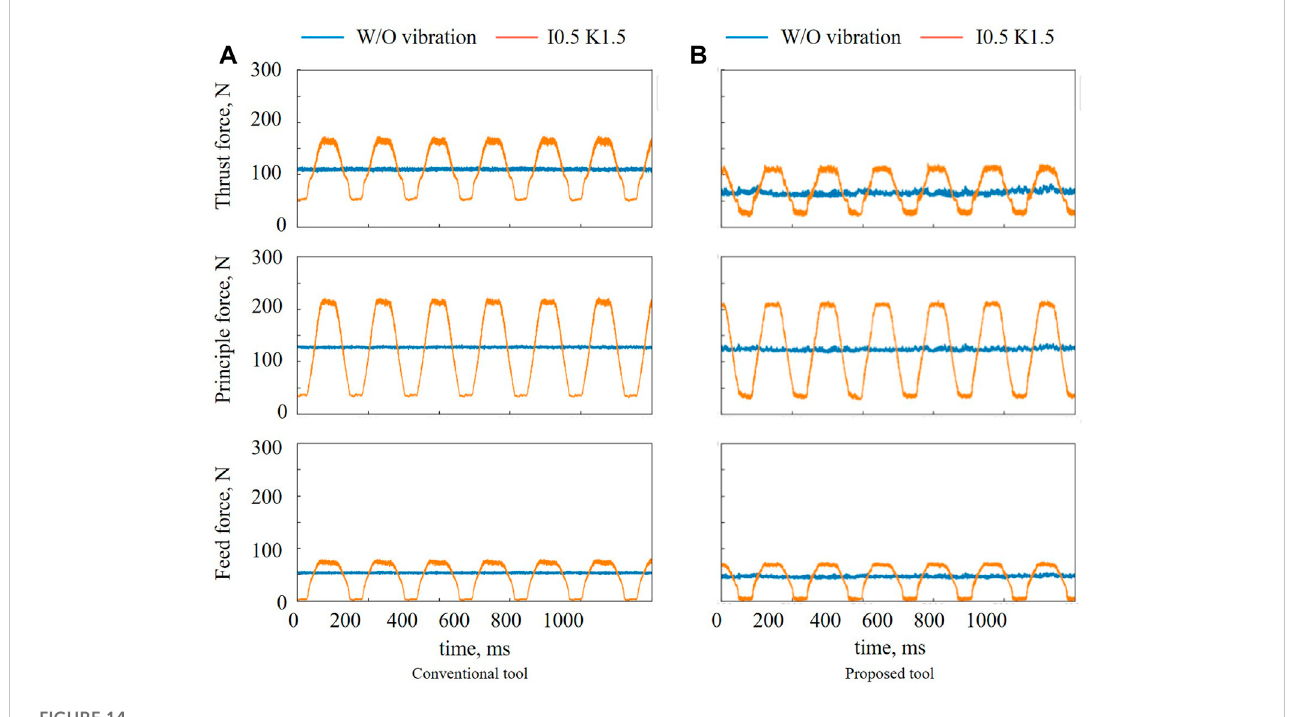
FIGURE 14 Cutting force results ( I = .5 and K = 1.5).